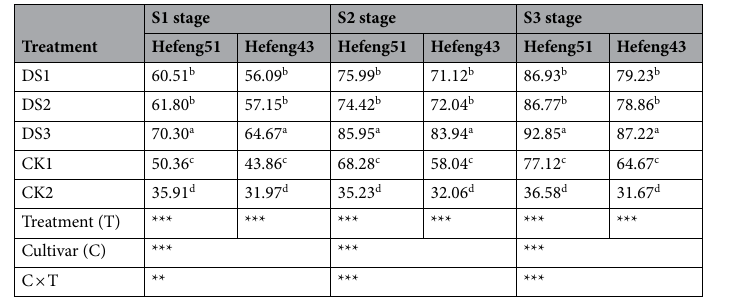
Table 3. Effects of foliar α-oxoglutarate and nitrogen on leaf proline content under drought stress (µg g −1 FW). Means with same letter within columns are not significantly different ( P < 0.05) using LSD test. ***, **Significance at 0.001, and 0.01,